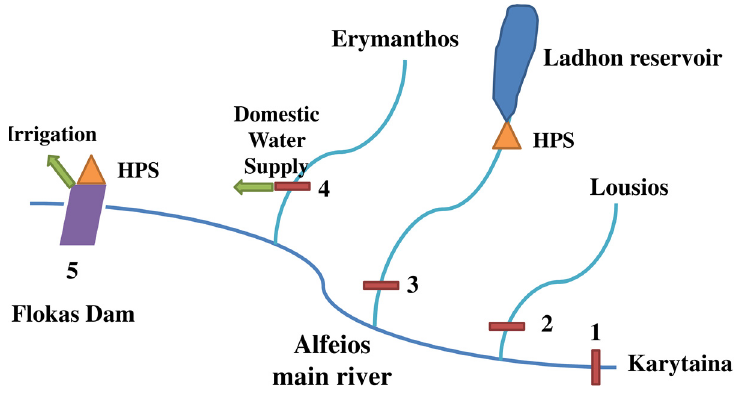
Figure 2. The simplified schematic of the Alfeios River